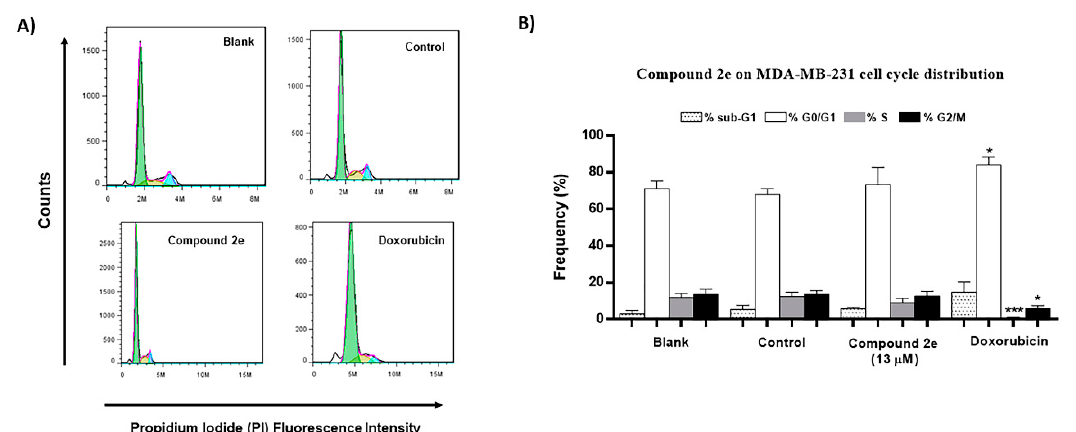
Figure 3. Effect of compound 2e on MDA-MB-231 cell cycle distribution, analyzed by flow cytometry following incubation with propidium iodide (PI). Cells were treated for 48 h with medium (Blank), control (DMSO; vehicle), compound 2e (at 13 µ M) and Doxorubicin (positive control; 50 nM). ( A ) Representative histograms of the MDA-M-231 cell cycle profile with the different treatments. ( B ) Percentage of MDA-MB-231 cells in the different phases of the cell cycle. Results represent the mean ± S.E.M. of at least three independent experiments. * p ≤ 0.05 and *** p ≤ 0.001 of Control vs.